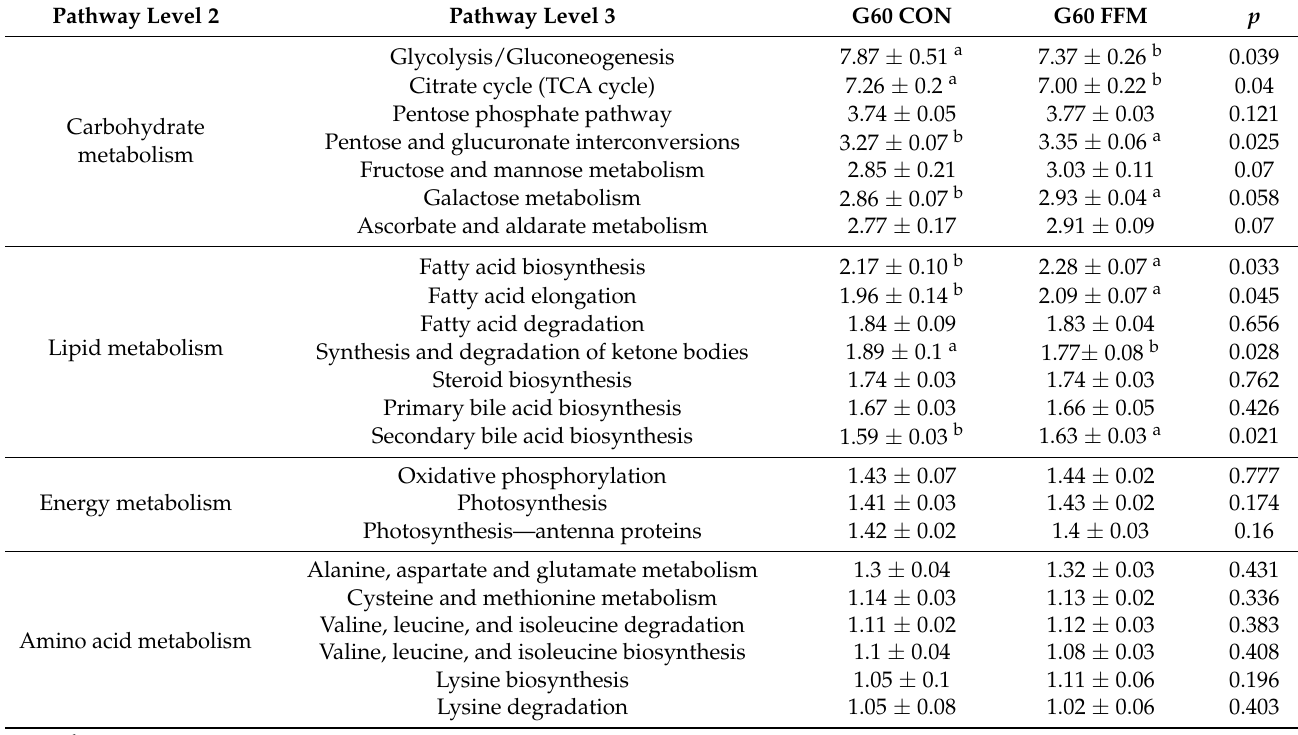
Table 7. The main microbial pathways are grouped into level 3 Kyoto Encyclopedia of Genes and Genomes (KEGG) functional